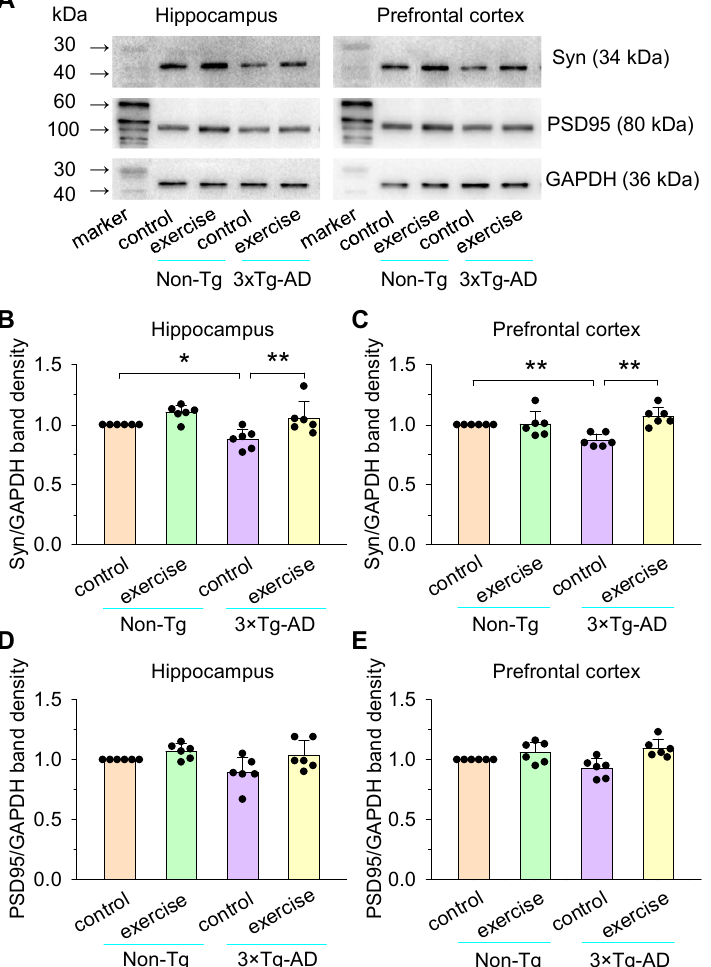
Figure 4. Treadmill exercise facilitates the expression of Syn and PSD95 of hippocampus and pre- frontal cortex in 3 × Tg-AD mice. ( A ) Representative western blots for Syn, PSD95, and GAPDH of hippocampus and prefrontal cortex homogenates were prepared from these four groups of mice. ( B , C ) Summarized data showed that Syn of hippocampus ( B ; * p < 0.05, n = 6) and prefrontal cortex ( C ; ** p < 0.01, n = 6) were significantly decreased in the 3 × Tg-AD control group compared to the non-Tg control group and this decrease was blocked by treadmill exercise pretreatment both in the hippocampus ( B ) and prefrontal cortex ( C ) (** p < 0.01, n = 6). ( D , E ) There were no significant effects on the PSD95 between non-Tg control, non-Tg exercise, 3 × Tg-AD control, and 3 × Tg-AD exercise mice in the hippocampus ( D ; p > 0.05, n = 6) and prefrontal cortex ( E ; p > 0.05, n = 6). Immunoreactiv- ity was normalized to GAPDH and presented as the percentage of the non-Tg control group. Each data set was obtained from 3